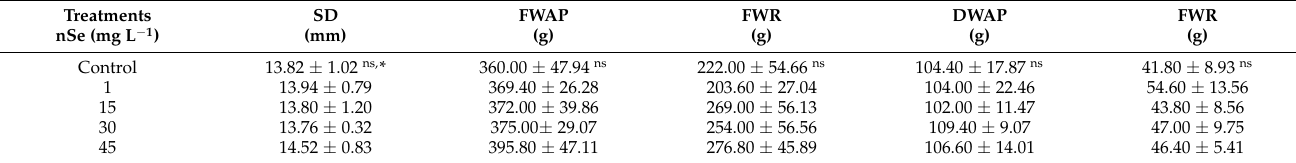
Table 1. Agronomic attributes of Jalapeño pepper crop with nSe